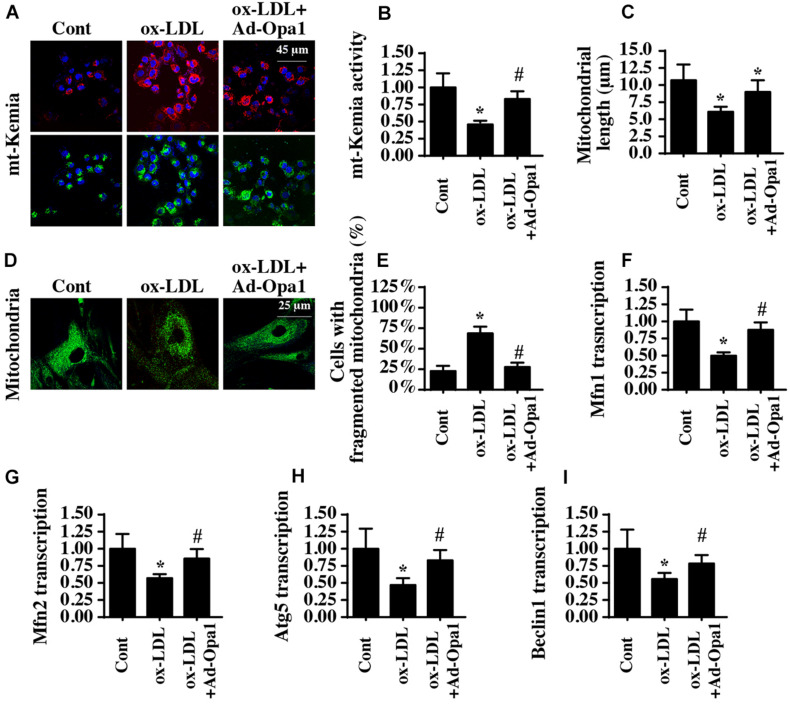
Ox-LDL-suppressed mitophagy and mitochondrial fusion can be reversed by Opa1 overexpression in endothelial cells. (A,B) mt-Kemia was used to observe the activity of mitophagy in ox-LDL-treated endothelial cells. Opa1 adenovirus was transfected into cells to overexpress Opa1. (C–E) Immunofluorescence of mitochondria morphology. The average length of mitochondria was determined. Opa1 adenovirus was transfected into cells to overexpress Opa1. (F–I) RNA was isolated from endothelial cells and the transcription of Mfn1, Mfn2, Atg5, and Beclin1 were determined through qPCR. *p < 0.05.